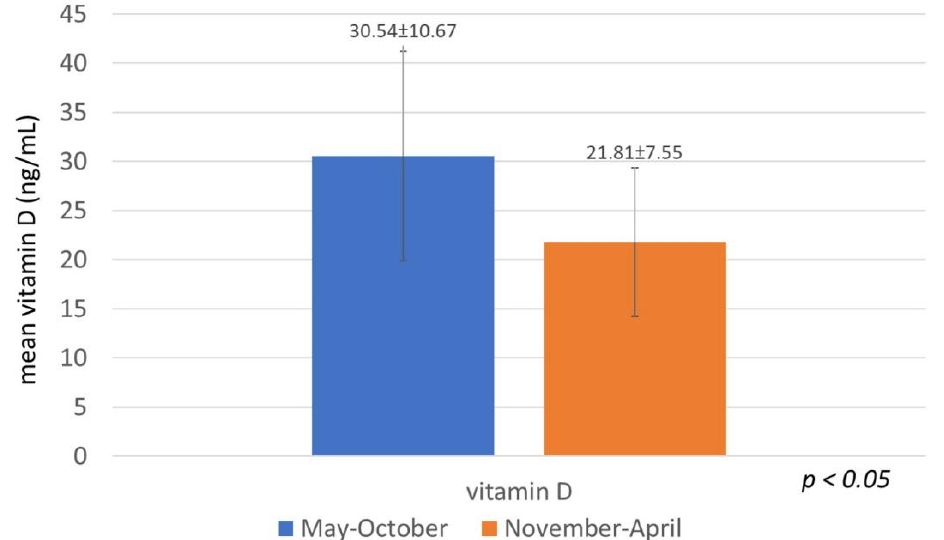
Figure 1. Mean serum level of vitamin D (25(OH)D, ng/mL) in healthy children in Greece during the months May–October and November–April. A comparison of the proportion of children and adolescents with vit D deficiency and insufficiency (Table 2) showed that children with deficiency or insufficiency were significantly older than those with normal serum levels of 25(OH)D. Adolescents (13–18 years) were deficient/insufficient in vit D during June and July, in contrast to the infants (Figure 2). Table 2. Vitamin D (vit D, 25(OH)D) deficiency and insufficiency in healthy children in Greece, according to demographic characteristics, month, and season ( n = 376).